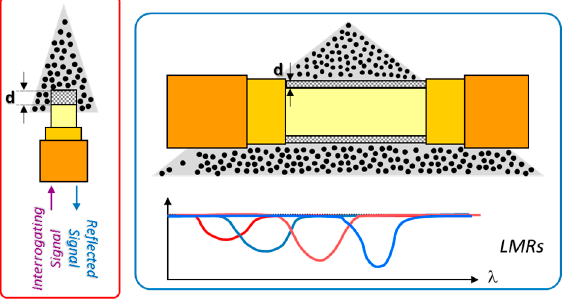
Figure 12. Sputtering deposition for a reflection sensor (on the left ) and for a transmission one (on the right ).